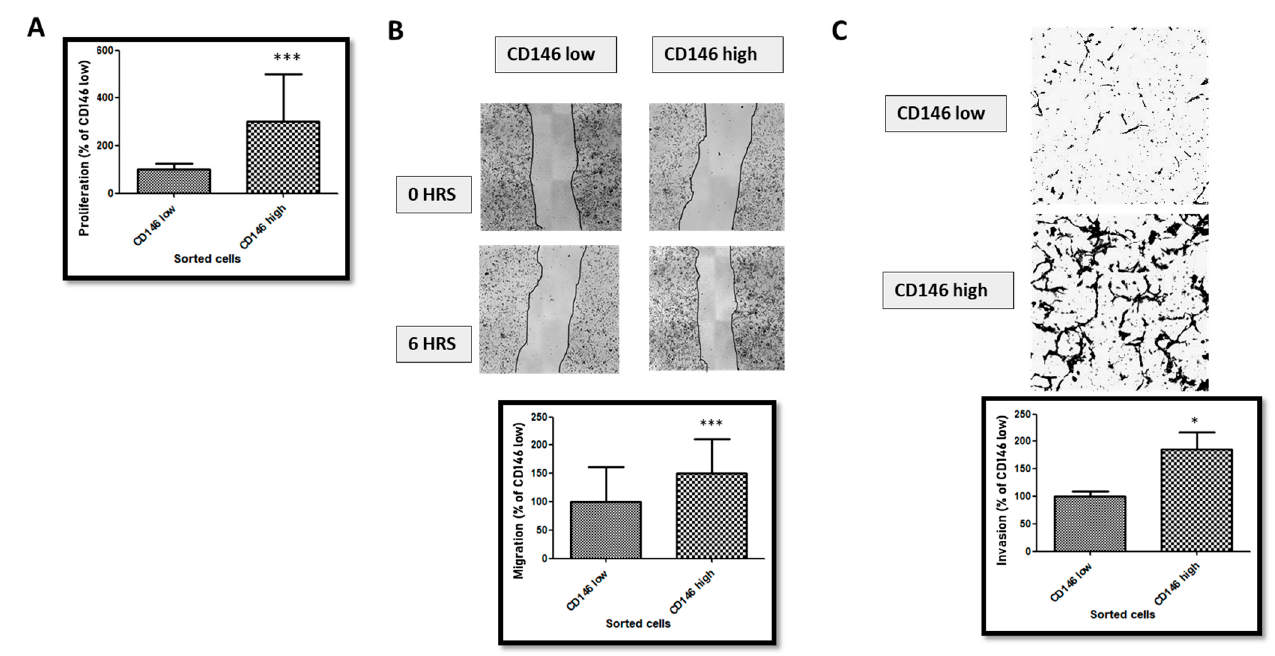
Figure 3. Proliferation, migration and invasion of CD146-low versus CD146-high cells. ( A ) Com- parison of proliferation rates in low- and high- CD146 MDA-MB-231 cells. ( B ) Comparison of migration rates in low- and high- CD146 MDA-MB-231 cells. Images show representative pictures of the migration assay, and the average of five experiments is given. ( C ) Comparison of invasion rates in low- and high- CD146 MDA-MB-231 cells. Images show representative pictures of the invasion assay, and the average of five experiments is given. *, ***: p < 0.05, p < 0.001, CD146 high vs. CD146 low.